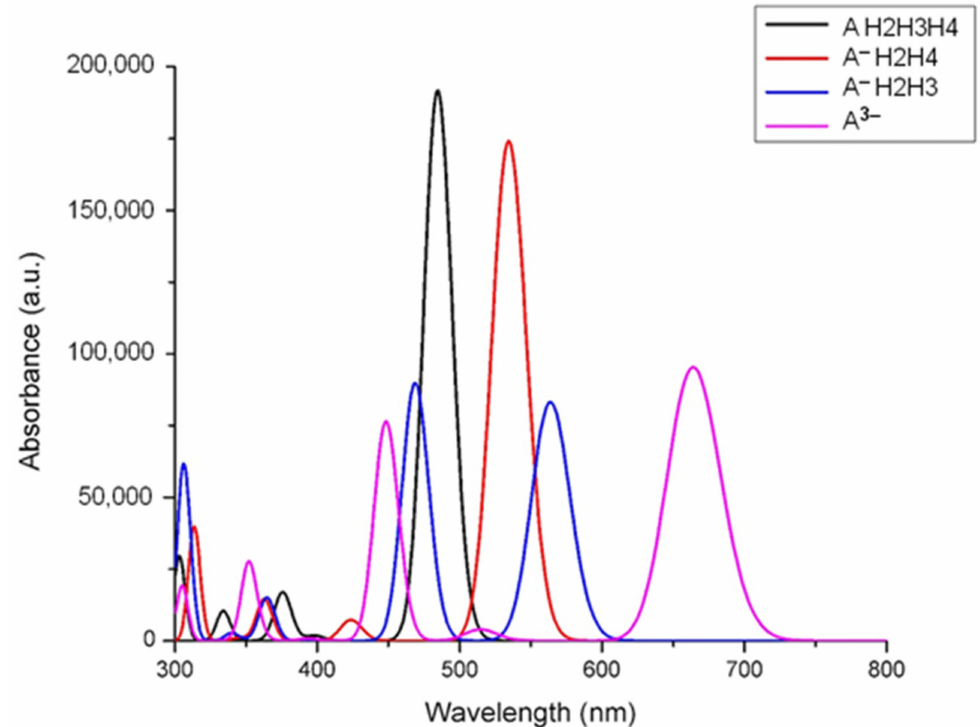
Figure 2. The calculated UV-Vis spectra of neutral and deprotonated species of cyanidin